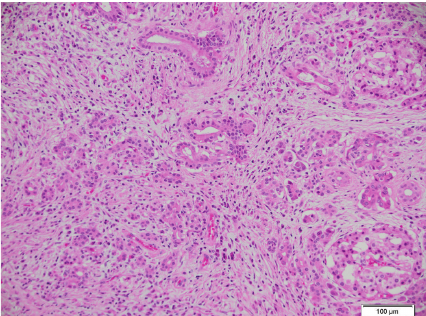
Figure 9: Histopathology showed inflammatory, sclerosing process involving benign region of pancreatic tissue. There was fibrosis atrophyofexocrineelementsandlymphoplasmacyticinflammation. Residual pancreatic islets are also